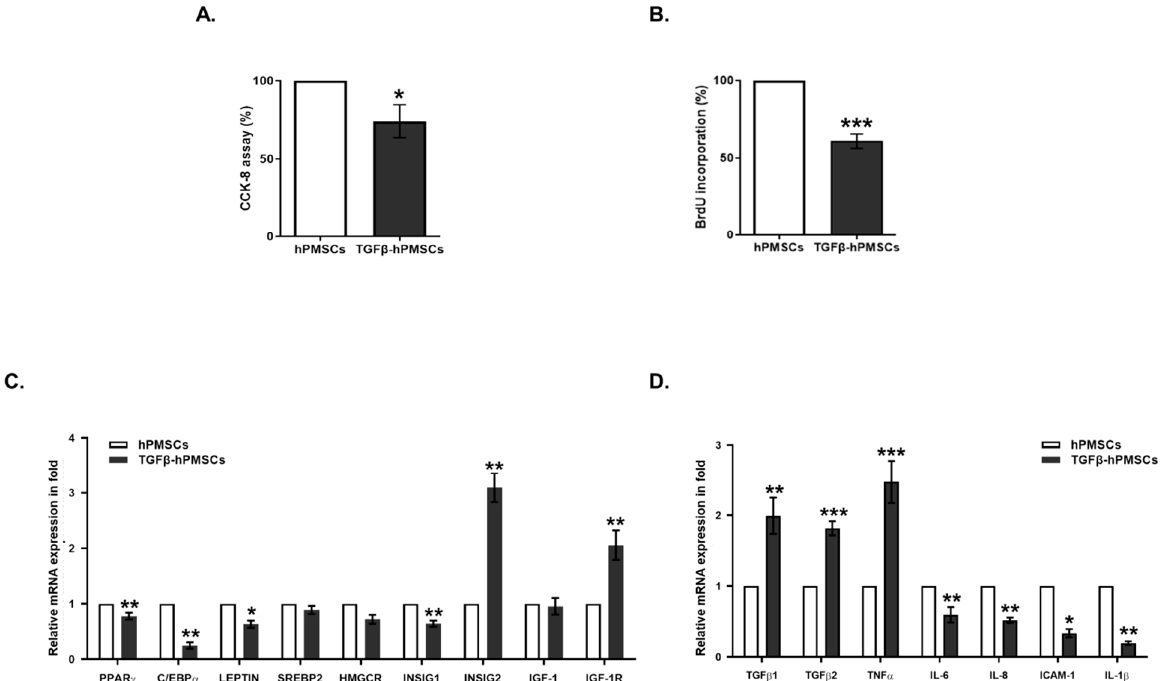
Figure 1. Characterization of hPMSCs with TGF β treatment. ( A ) Cell viability was determined by CCK-8 assay and ( B ) BrdU assay at 24 h after TGF β (20 ng/mL) treatment. ( C ) The relative mRNA expressions of adipogenesis and lipogenesis marker genes (e.g., PPAR γ , C/EBP α , LEPTIN , SREBP2 , HMGCR , INSIG1 , INSIG2 , IGF-1 , and IGF-1R ) were analyzed by RT-qPCR after TGF β treatment. ( D ) The relative mRNA expressions of inflammation marker genes (e.g., TGF β 1 , TGF β 2 , TNF α , IL-6 , IL-8 , ICAM-1 , and IL-1 β ) were analyzed by RT-qPCR at 24 h after TGF β treatment (* p < 0.05, ** p < 0.01, *** p < 0.001 vs.